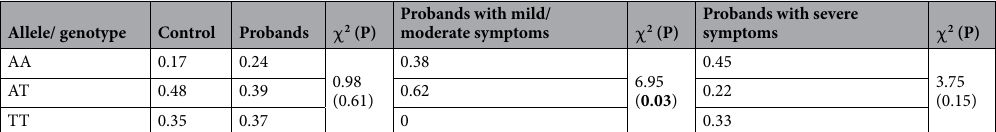
Table 2. Population based analysis on rs3810651 genotype frequency of female subjects. N.B: Statistically significant difference is presented in bold.